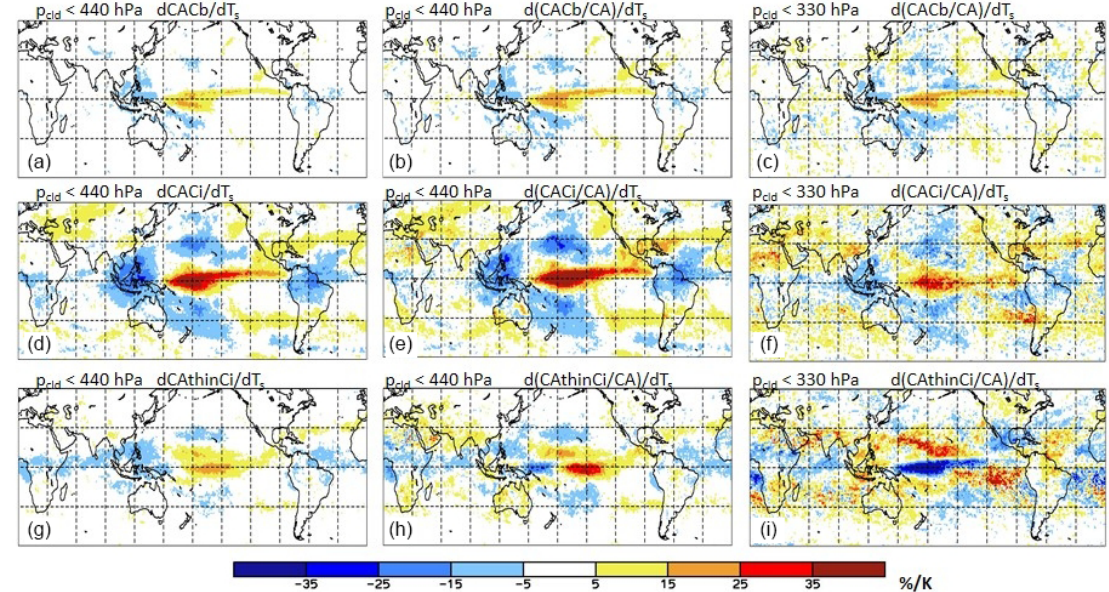
Figure 12. Geographical maps of linear regression slopes between monthly mean anomalies in amount of Cb ( ε cld >0.95; a–c ), Ci (0.95> ε cld >0.4; b, d, h ) and thin Ci (0.4> ε cld >0.1; g–i ) from AIRS-CIRS and global mean surface temperature anomalies from ERA- Interim. (a, d, g) p cld <440hPa; (d–f) relative cloud amount; (c, f, i) p cld <330hPa and relative cloud amount. Results using 156 months during the period